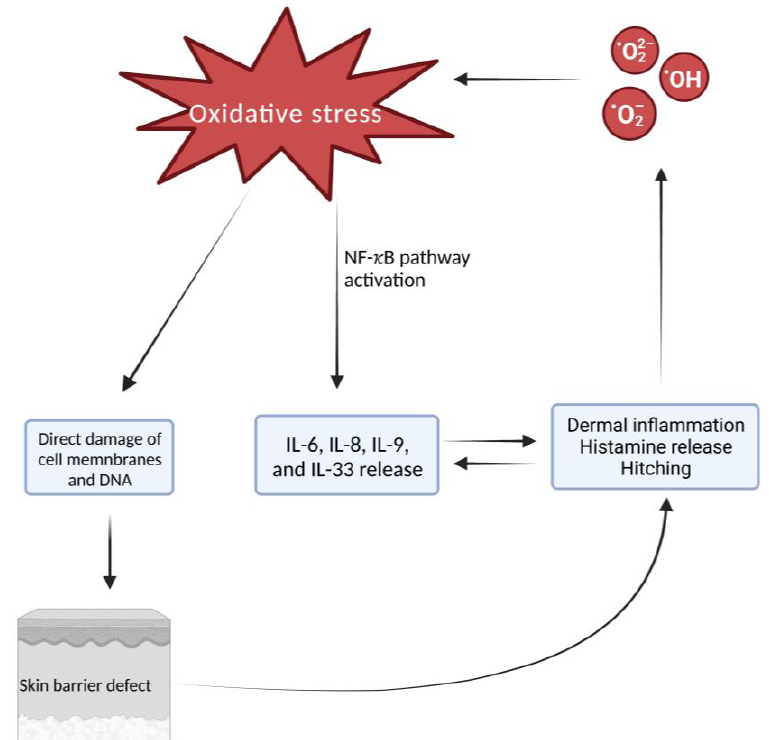
Figure 1. Oxidative stress causes direct damage to the cell membrane and DNA which leads to skin barrier defect. Furthermore, the activation of the NF- κ B pathway leads to the release of IL-6, IL-8, IL-9, and IL-33. The defect of the skin barrier causes inflammation of the dermis and release of histamine and itching, leading in turn to an increased release of IL-6, IL-8, IL-9, and IL-33. All these mechanisms determine a further increase in the release of ROS, establishing a vicious circle that is self-maintaining. Created with BioRender.com.